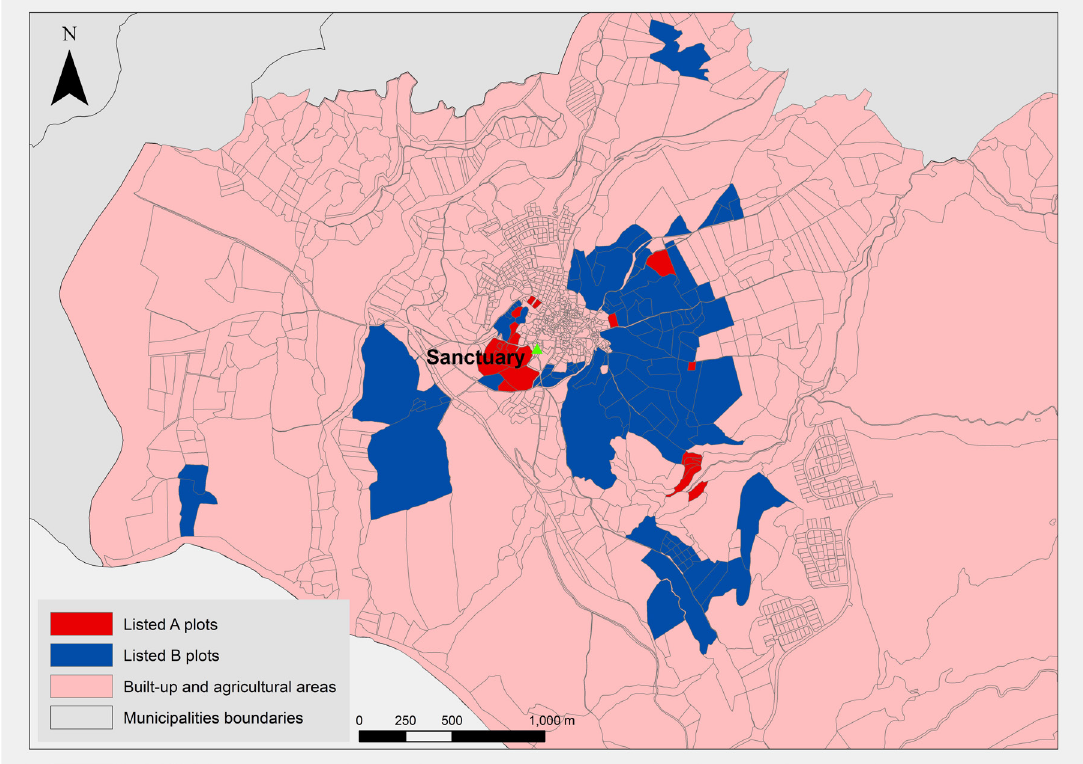
Figure 8. Protected parcels within the Kouklia municipal boundaries. Drafted by A. Agapiou